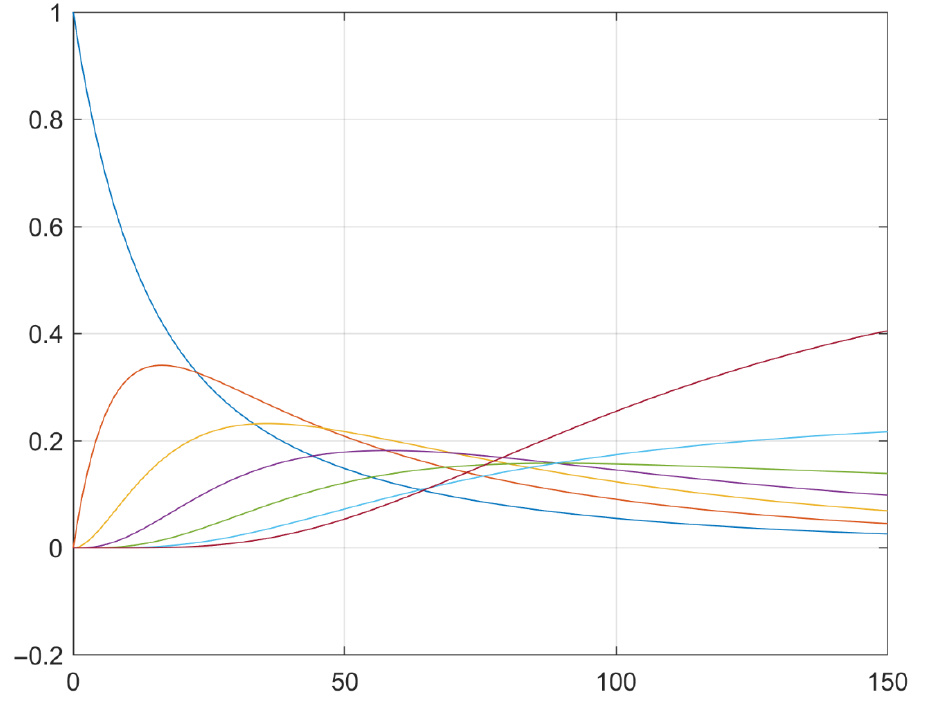
Figure 3. Probability distribution of the system being in a certain state ( X -axis is the distribution time, Y -axis is the probability of the system being in a certain state).